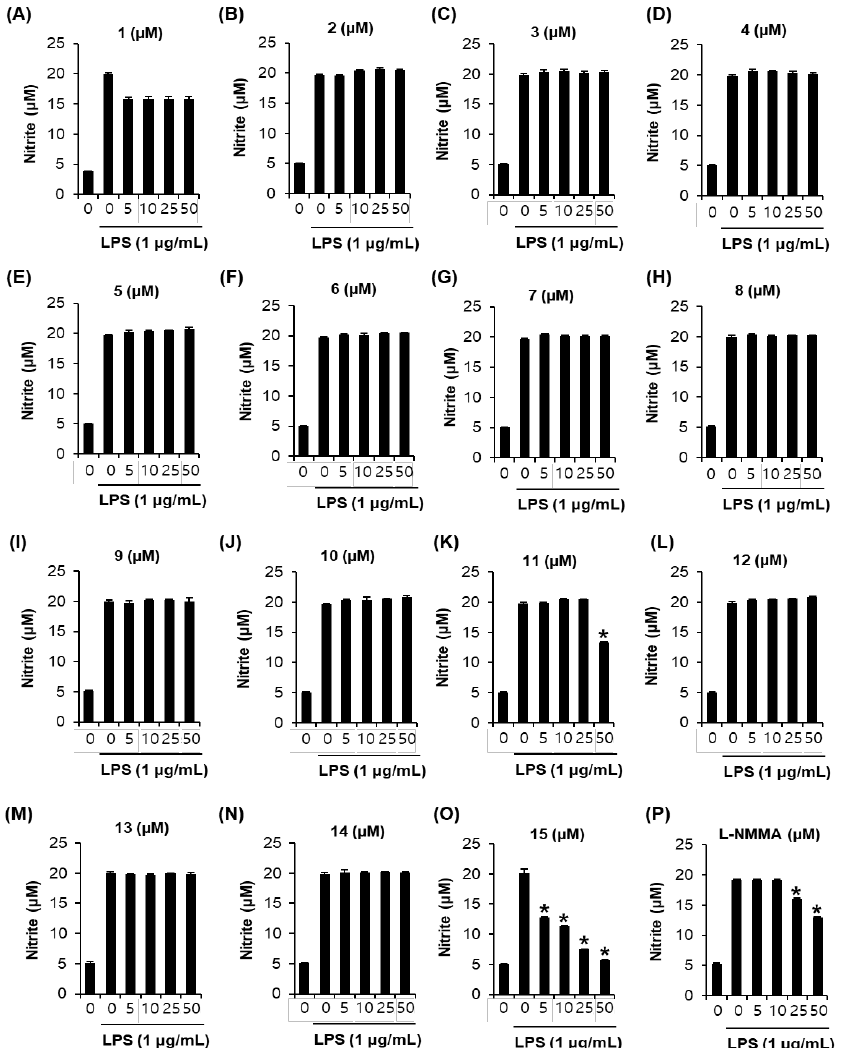
Figure 3. Effects of compounds 1–15 and N G -monomethyl-L-arginine mono-acetate salt (L-NMMA) in RAW 264.7 mouse macrophages treated with lipopolysaccharide (LPS). ( A – P ) The effects of com-